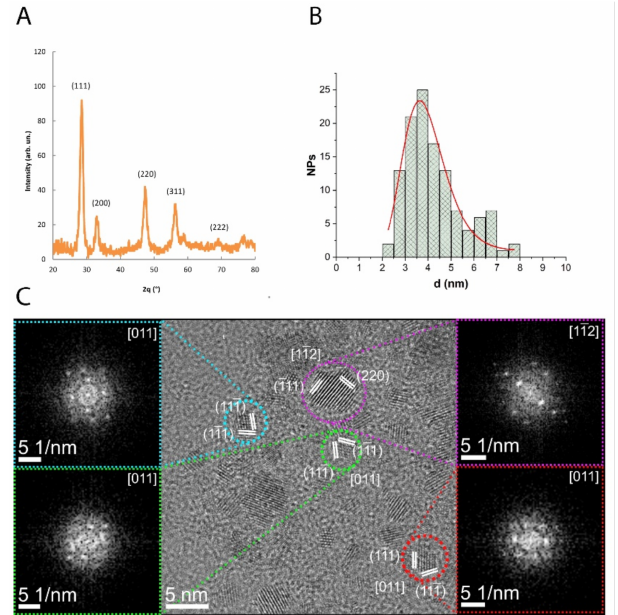
Figure 1. Physicochemical characterization of the synthetized CNP. ( A ) XRD pattern. ( B ) CNP diameter distribution as measured from several HRTEM images, fitted with a log-normal function (red line). ( C ) HRTEM images of representative CNP. Magnified regions show the single-crystalline structure of CNP, confirmed by the 2D-FFT diffractograms. For improved readability, only the main lattice planes are indicated in the insets.